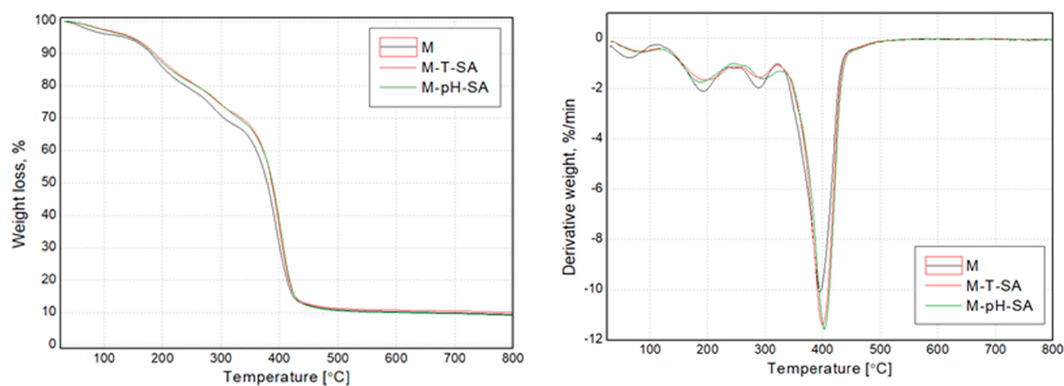
Figure 6. TG and DTG curves of the thermo- and pH-sensitive nanocarriers, salicylic acid, and sys- tems of nanocarriers with SA.